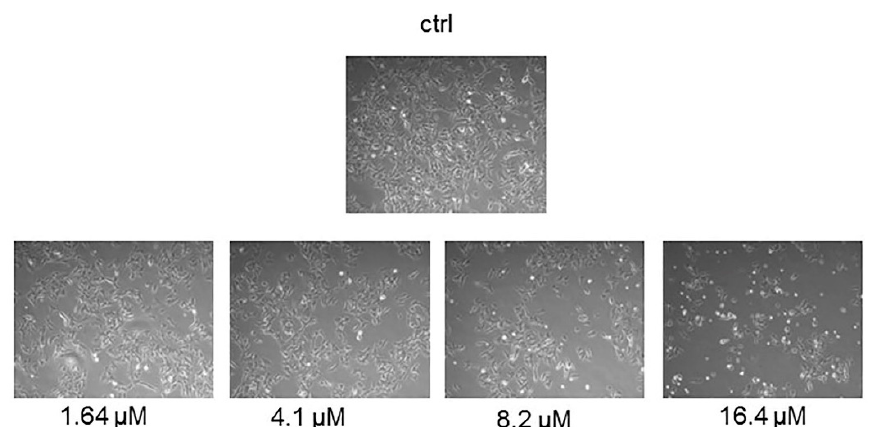
Figure 3. Morphological analyses of the SH-SY5Y cells treated with moringin. Cell morphology was monitored after treatment with di ff erent concentrations (1.64–16.4 µ M) of moringin for 24 h. The morphological changes were observed under an inverted microscope (200 × ).